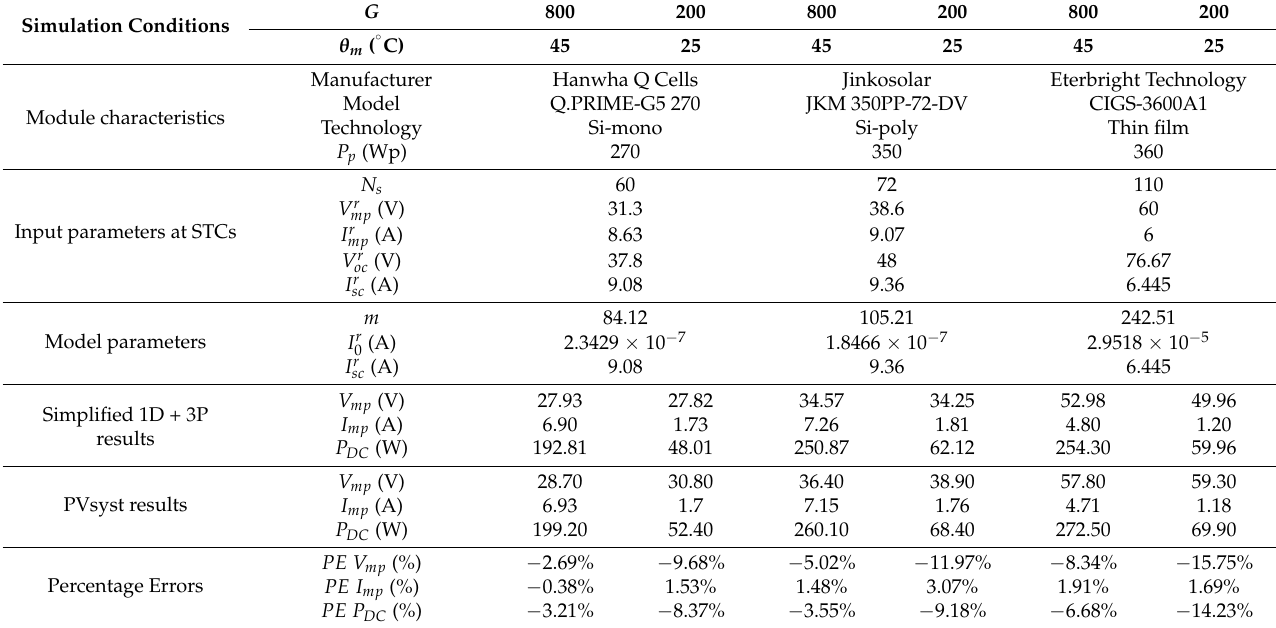
Table 10. Detailed comparison of the simplified 1D + 3P model electrical quantities computation and the same results provided by PVsyst; Percentage Errors of the maximum power voltage ( V mp ), maximum power current ( I mp ) and output power ( P DC